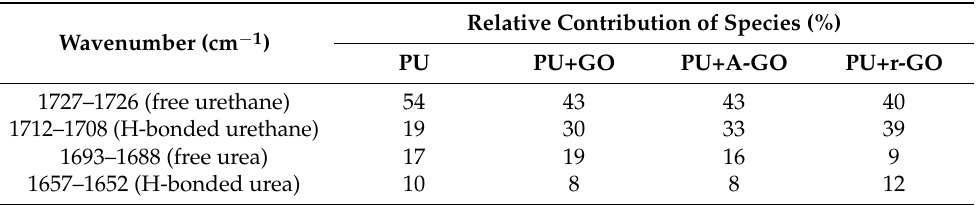
Table 6. Relative contributions of the free and associated by hydrogen bond (H-bonded) urethane and urea species in the PUs. Curve fitting of the carbonyl region of the ATR-IR spectra. Relative Contribution of Species (%) Wavenumber (cm − 1 ) PU PU+GO PU+A-GO PU+r-GO 1727 – 1726 (free urethane) 1712 – 1708 (H-bonded urethane)